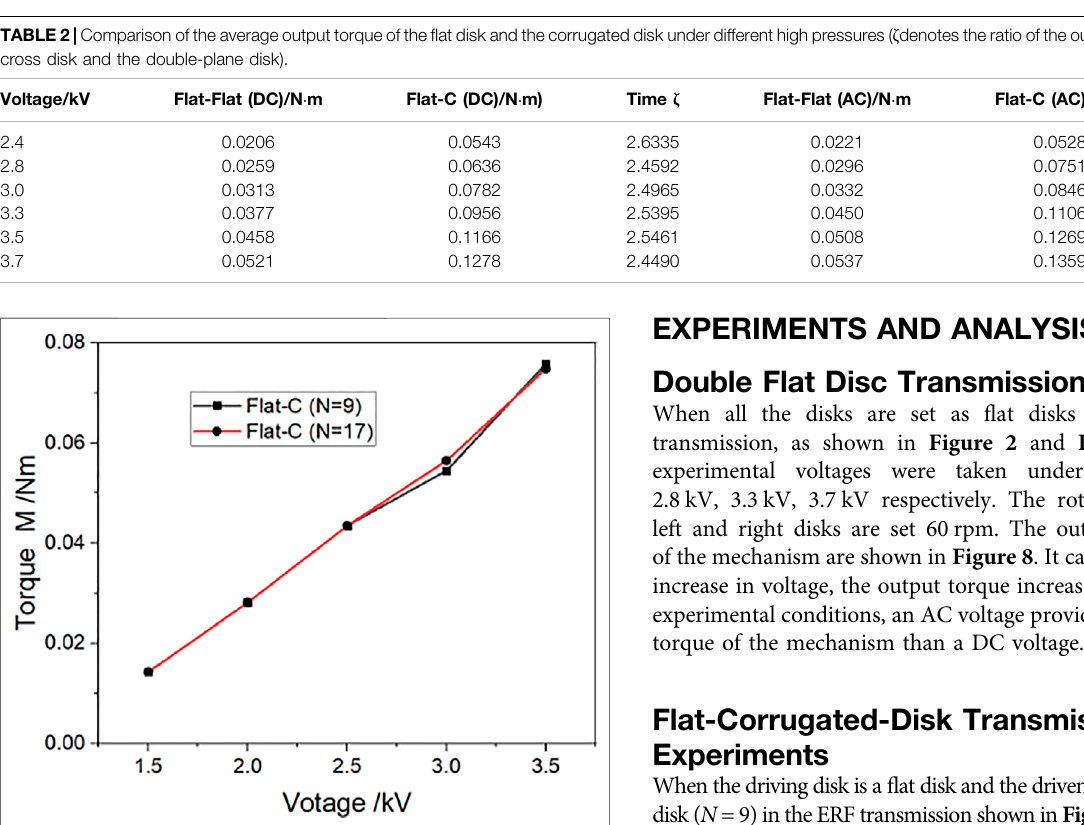
viscosity, dielectric constant and electrical loss of ER fl uids. In ambient temperature was set to 21 ° C.